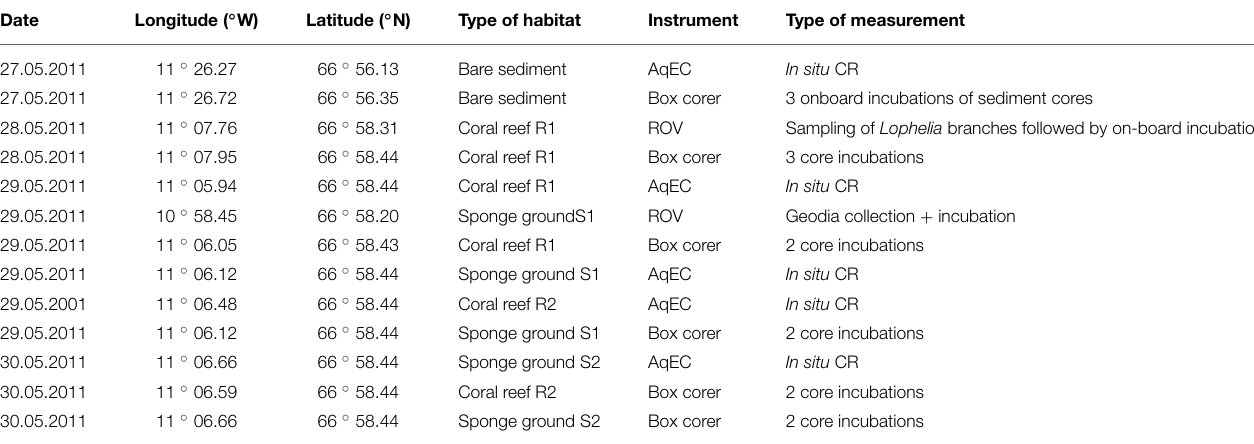
TABLE 1 | Station locations and instrument